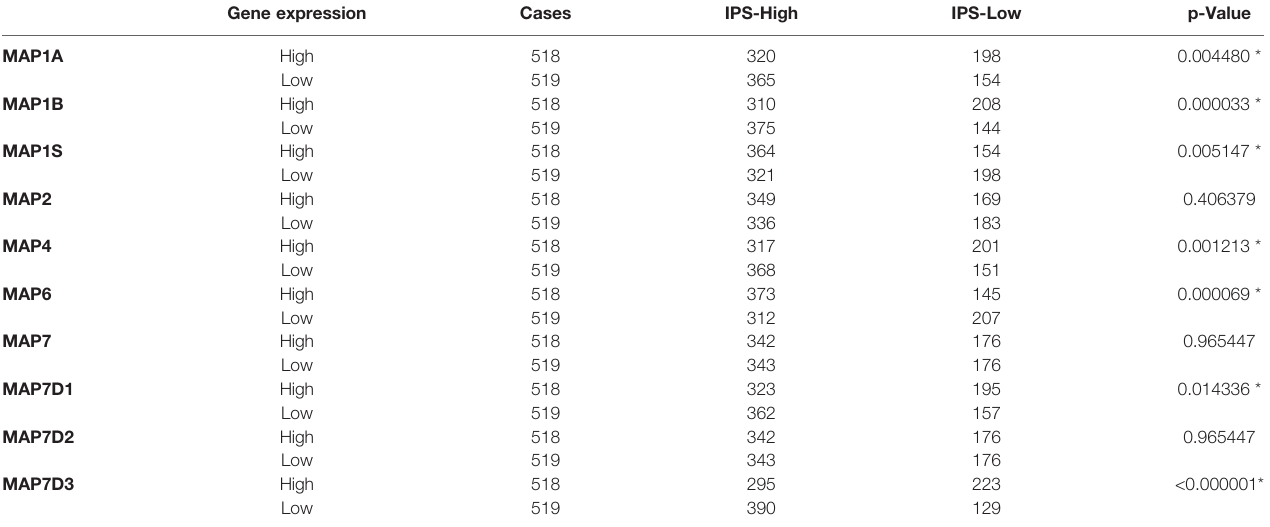
TABLE 2 | Correlations between MAPs and IPS (chi-square test). Gene expression Cases IPS-High IPS-Low p-Value MAP1A